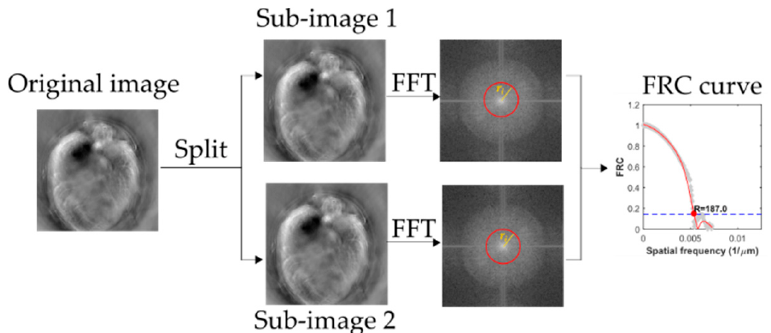
Figure 2. Resolution estimation based on Fourier ring correlation (FRC).